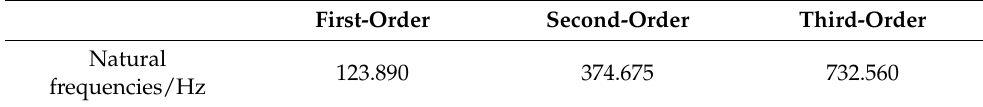
Table 2. The natural frequencies of the corresponding integral